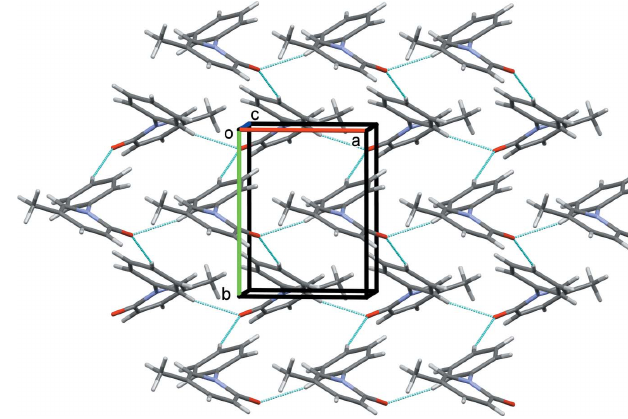
Figure 2 A view along the a axis of the crystal packing of pirfenidone. The C— H (cid:3)(cid:3)(cid:3) O hydrogen bonds (see Table 1) are shown as dashed lines.